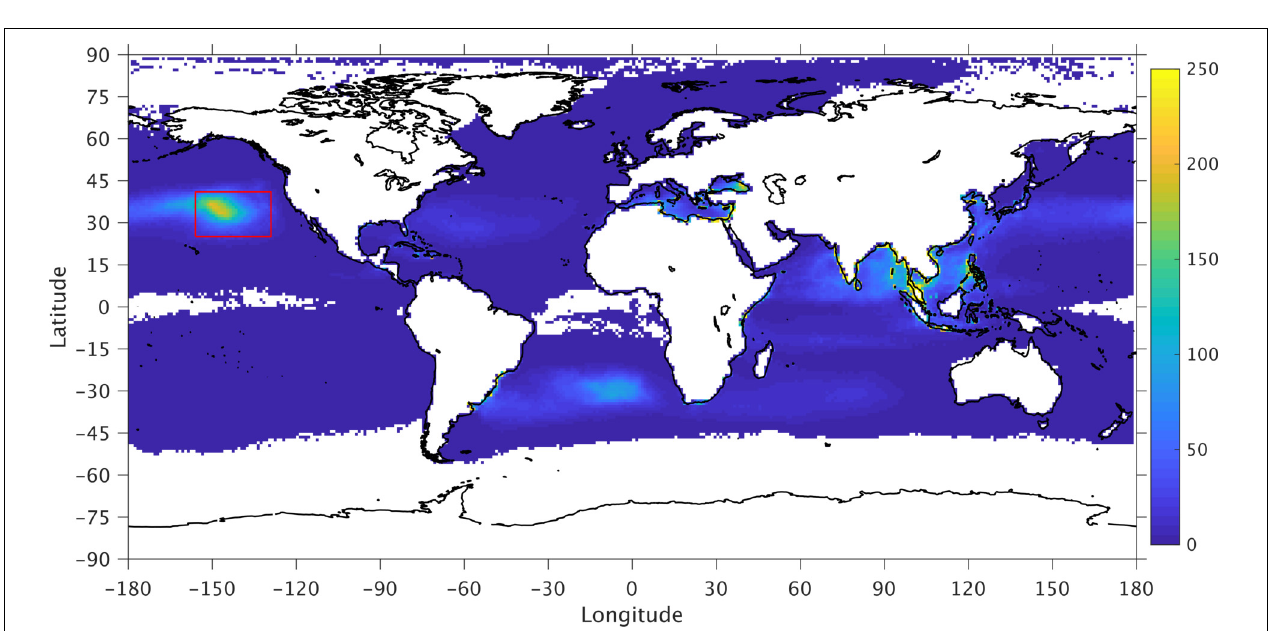
FIGURE 6 | Similar to Figure 3 , but for the time-averaged modeled mismanaged plastic waste concentration (in kg/km 2 ) from 2017 to 2019.